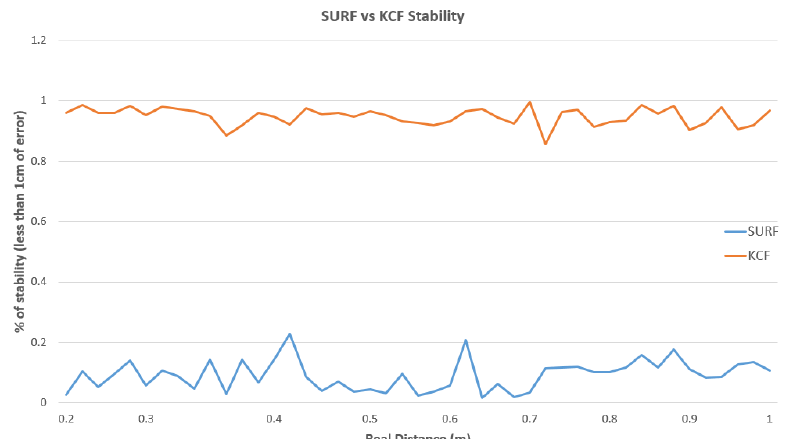
Figure 18. Difference of stability in the performance of the two solutions proposed (SURF-based and KCF-based), where the abscissa axis represents the distance to the target and the ordinate axis the percentage of frames providing the correct measurement. Table 3. Stability and accuracy from both solutions presented. Real